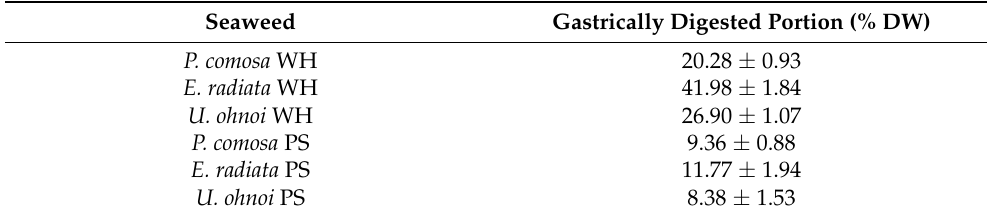
Table 6. Percentage of WH seaweed and PS extracts digested after simulated gastric digestion (percentage ±